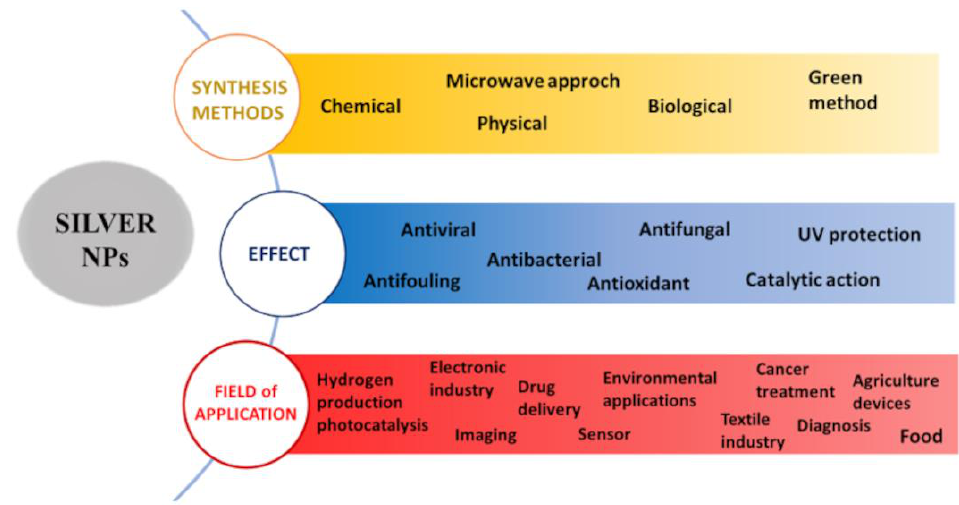
Figure 2. Main synthesis methods, effects and potential applications of AgNPs.